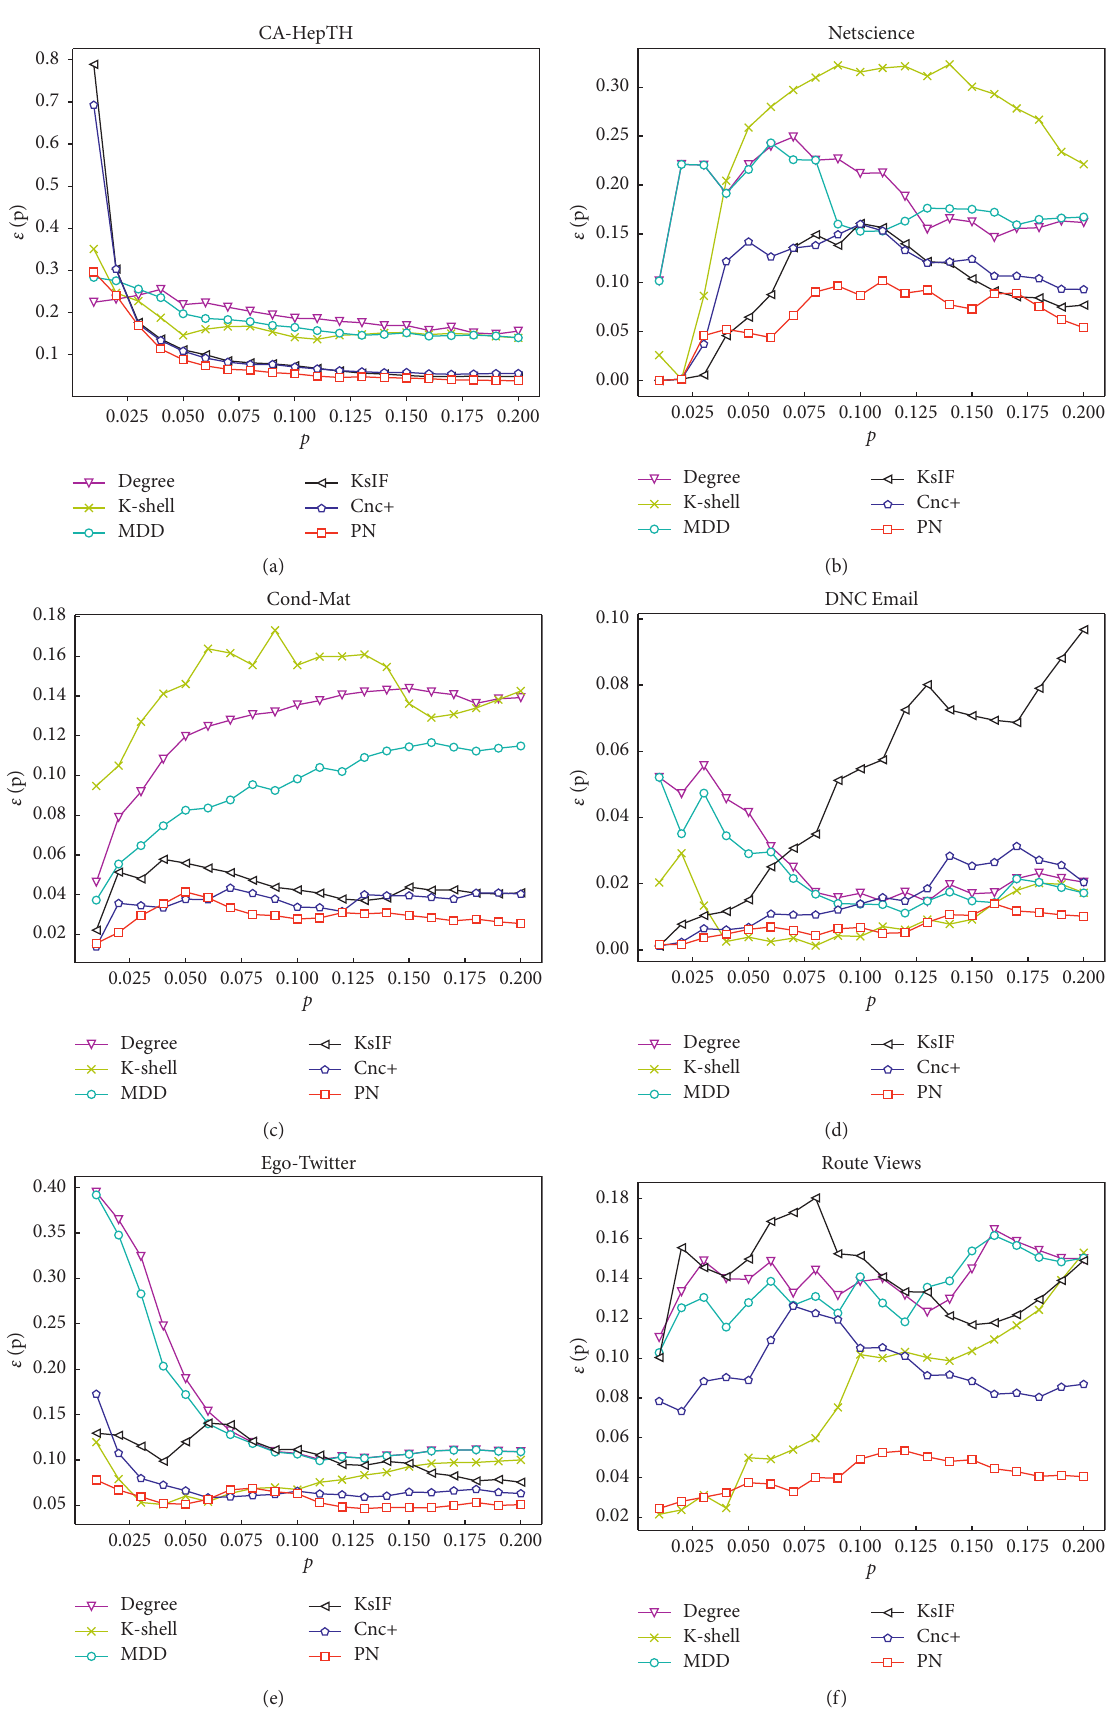
Figure 4: The imprecision of six ranking methods with different proportion of top-ranked nodes. The experiments are simulated on six different datasets: CA-HepTh (a), Netscience (b), Cond-Mat (c), DNC Email (d), Ego-Twitter (e), and Route Views